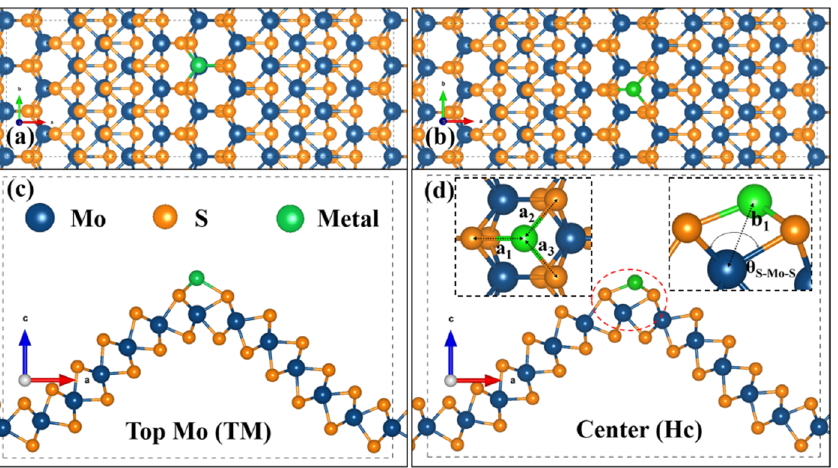
Figure 1. Representative configuration of the metal atom adsorbed on the crest of cMoS 2 . ( a , b ) are the top view of the TM site and Hc site; ( c , d ) are the corresponding side views.